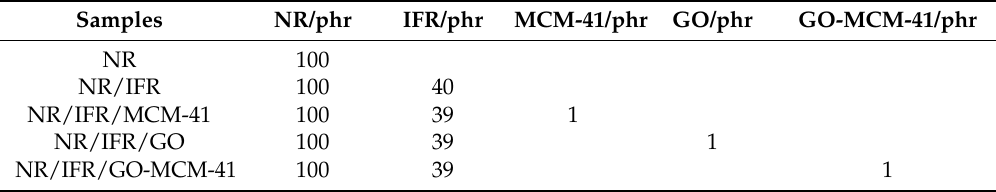
Table 1. Ingredients of NR